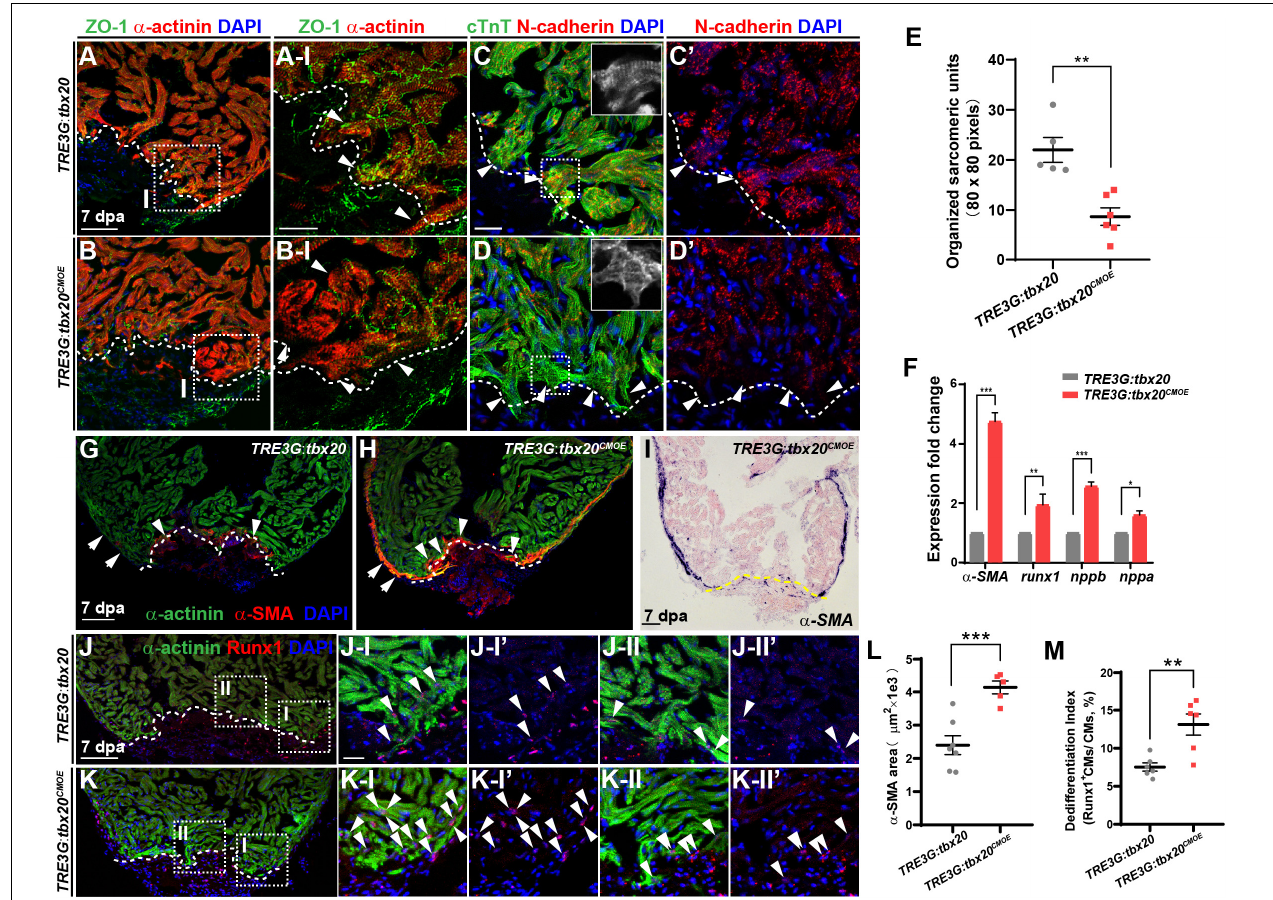
FIGURE 3 | tbx20 overexpression in the adult myocardium enhances CM dedifferentiation after injury. (A–D,G,H,J,K) Representative confocal fluorescence images of sections of injured ventricles from Tg ( TRE3G:tbx20 ) and Tg ( TRE3G:tbx20 CMOE ) zebrafish co-stained with antibodies against ZO-1 (green) and α -actinin (red) (A,B) , cTnT (green) and N-cadherin (red) (C,D) , α -SMA (red) and α -actinin (green) (G,H) , and Runx1 (red) and α -actinin (green) (J,K) . DAPI was used to stain nuclei. Boxed areas in (A,B,J,K) are magnified on the right with split channels. Insets in (C,D) show enlarged images of the dashed boxes. Arrowheads in (A-I, B-I) indicate CMs with disassembled sarcomeric structure in the border zone adjacent to the injury site. Arrowheads in (C,D) point to CMs adjacent to the injury site. Arrows and arrowheads in (G,H) indicate α -SMA + cells in the regenerating compact layer and trabecular layer, respectively. Arrowheads in (J,K) indicate Runx1 + α -actinin + CMs. (E) Quantification of organized sarcomeric units in cTnT-labeled myocardium (80 × 80 pixels) in border zone from 7 dpa ventricle sections of Tg ( TRE3G:tbx20 ) (C , n = 5) and Tg ( TRE3G:tbx20 CMOE ) ( D , n = 6) zebrafish. (F) Statistical analyses of qPCR for α -SMA , runx1 , nppb and nppa in the injured ventricle apices from Tg ( TRE3G:tbx20 ) and Tg ( TRE3G:tbx20 CMOE ) zebrafish at 7 dpa. (I) Representative images of ISH with α -SMA on 7 dpa heart sections from Tg ( TRE3G:tbx20 CMOE ) fish. (L) Dot plot showing the area of α -SMA stained on heart sections in (G , n = 7) and (H , n = 5). (M) Dot plot showing the percentage of Runx1 + α -actinin + cells in the border zone in (J,K) , n = 6 in each group. All fish were treated with DOX as described in Figure 2B and hearts were harvested at 7 dpa. Dashed lines delineate injured area. The values in (E,F,L,M) are mean ± SEM, ∗ p < 0.05, ∗∗ p < 0.01, ∗∗∗ p < 0.001. Scale bar: 50 µ m (A,B) ; 20 µ m (A-I,B-I,C-D’,J-I-K-II”) ; 100 µ m (G–K)